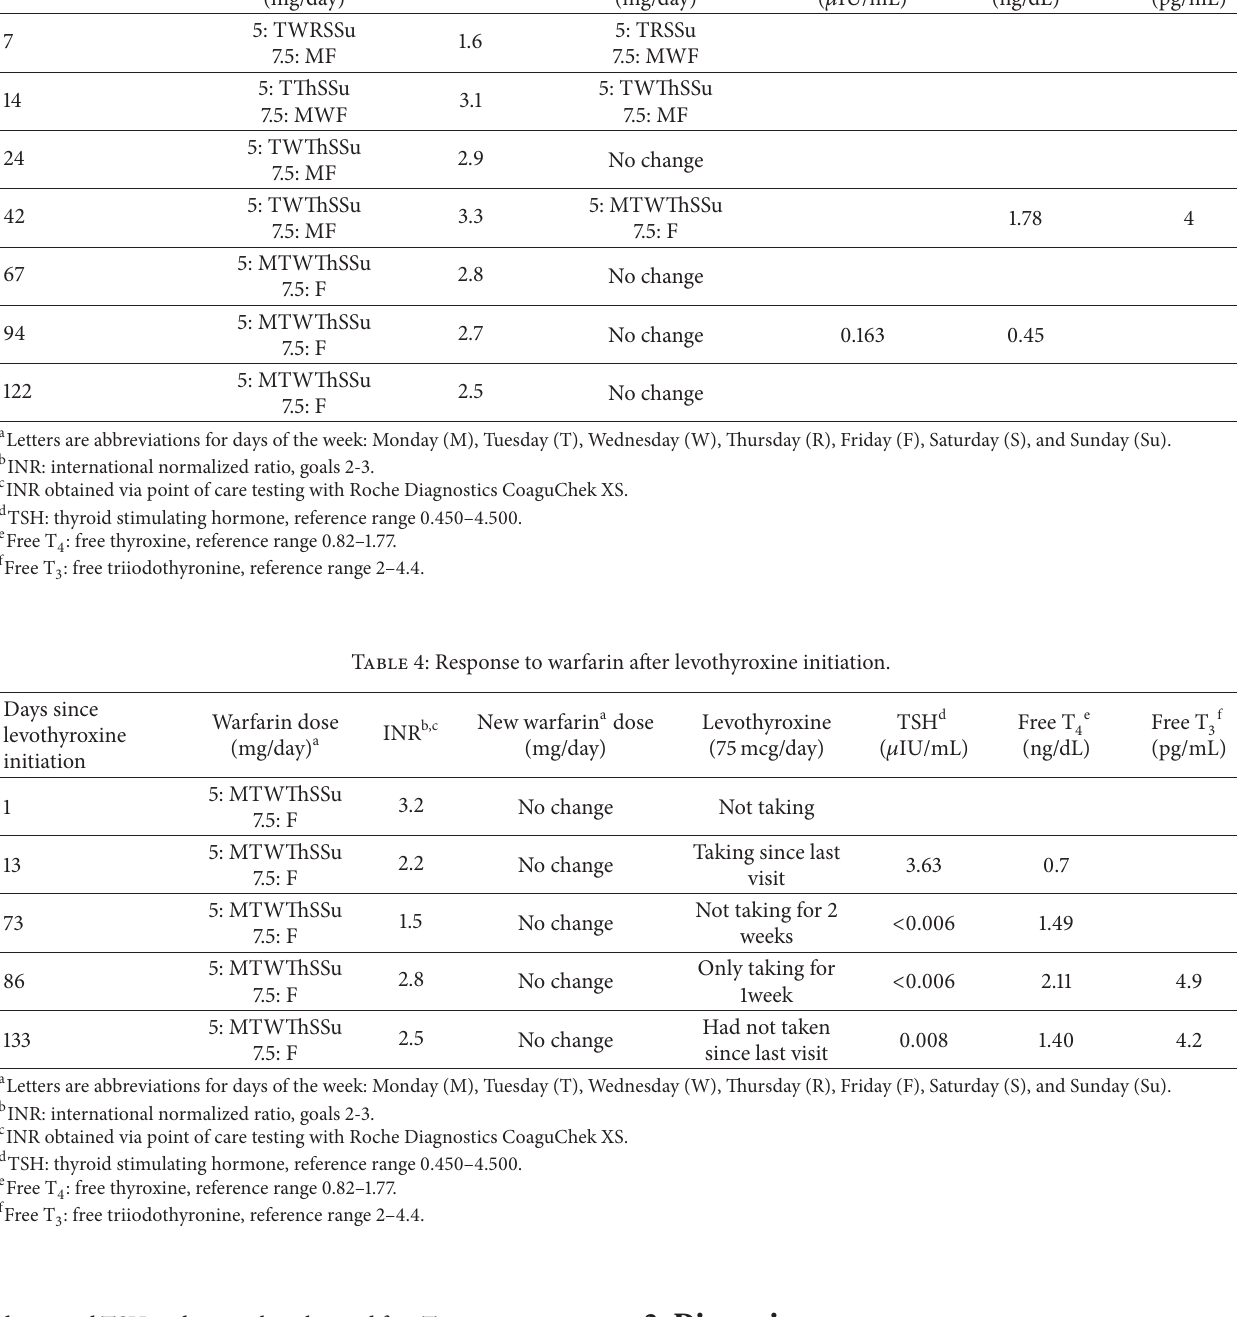
Table 3: Outpatient warfarin response status after radioactive iodine ablation of the thyroid and discontinuation of methimazole. Days since ablation